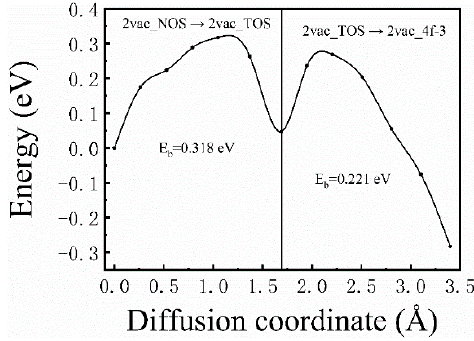
Figure 6. The corresponding di ff usion barrier energies of 2vac_NOS → 2vac_TOS → 2vac_4f −